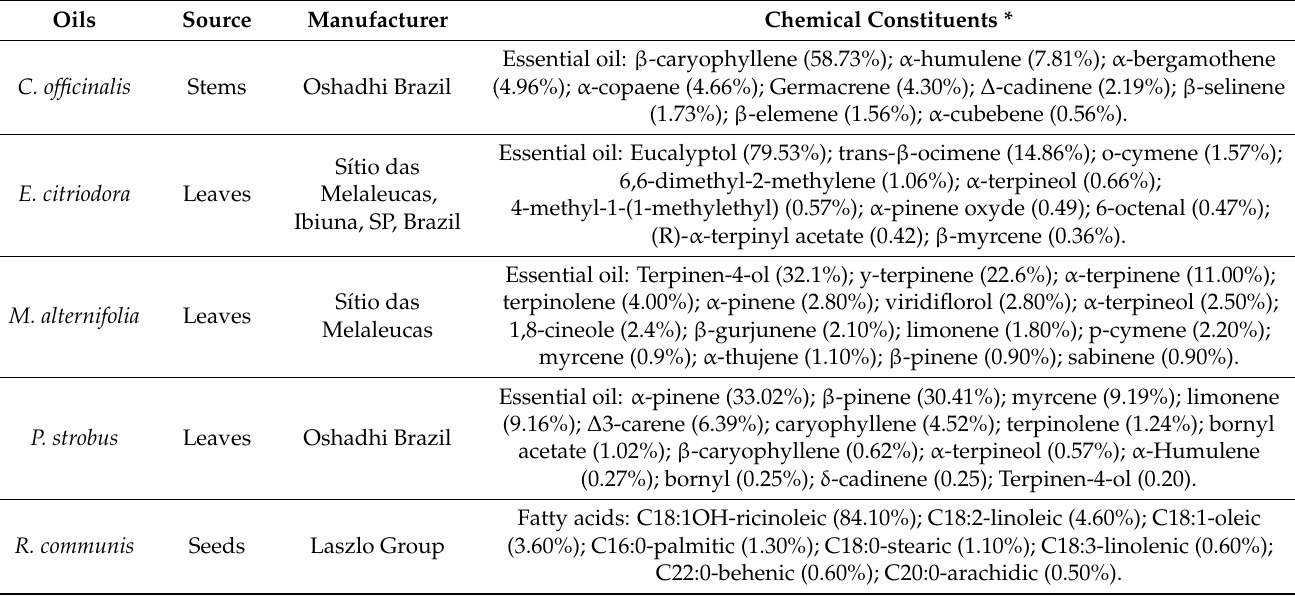
Table 5. Chemical characterization of the